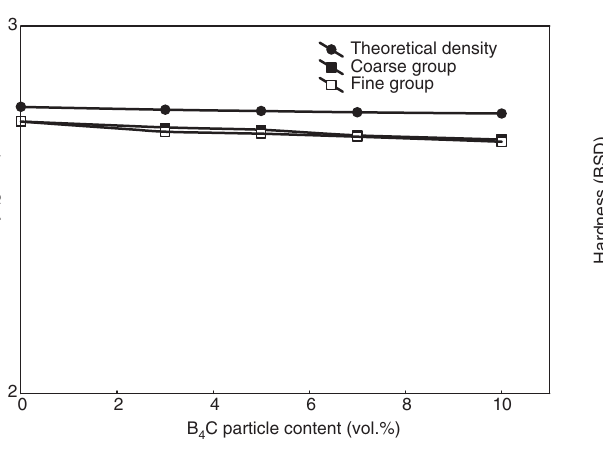
C particle content 4